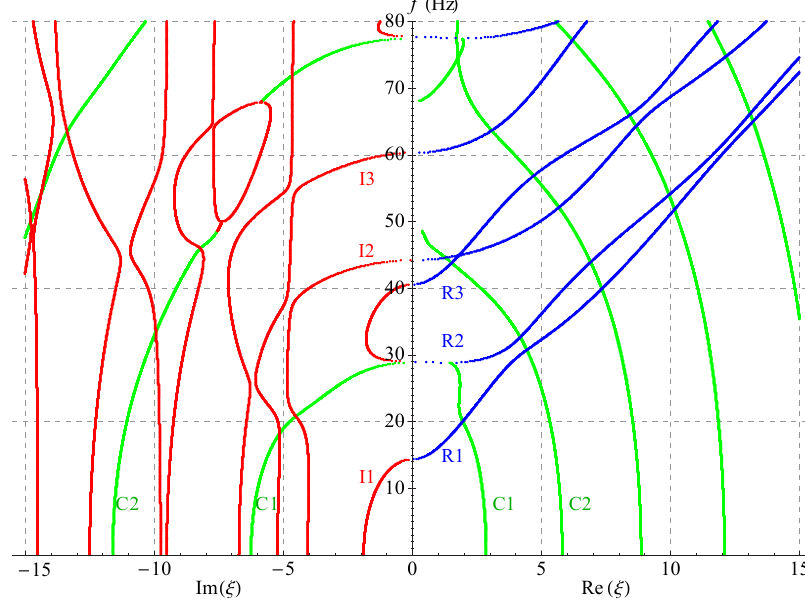
Figure 6. Two-dimensional full frequency spectra ( n = 2).